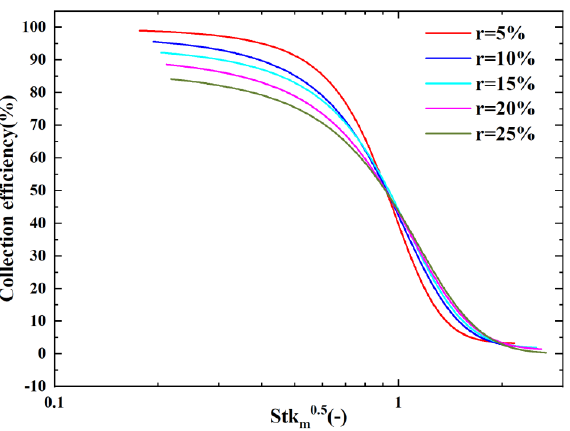
Figure 10. Effect of r on the CE curves using Stk m 0.5 as the absciss.